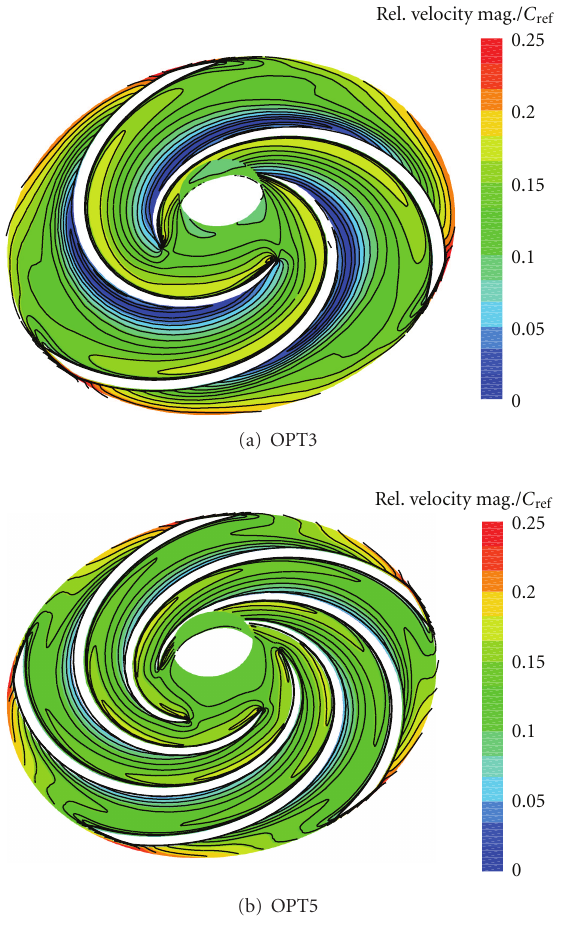
Figure 11: 3D view of the impeller flow field at DP ( N s = 9 . 5).